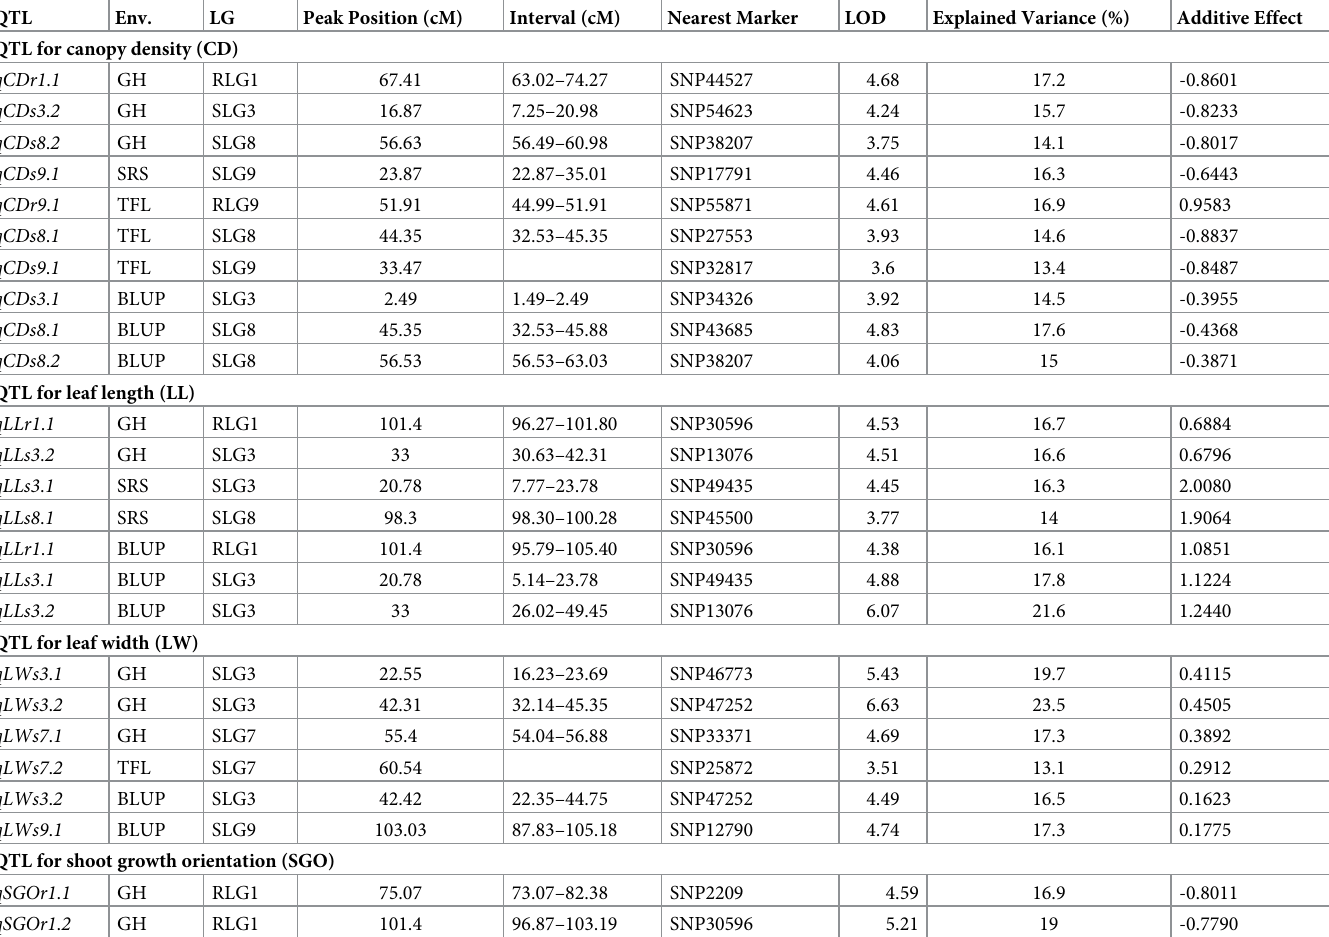
Table 2. Quantitative trait loci (QTL) found to have association with morphological traits in a St. Augustinegrass Raleigh x Seville F 1 population evaluated in green- house (GH) and two field (TFL and SRS)